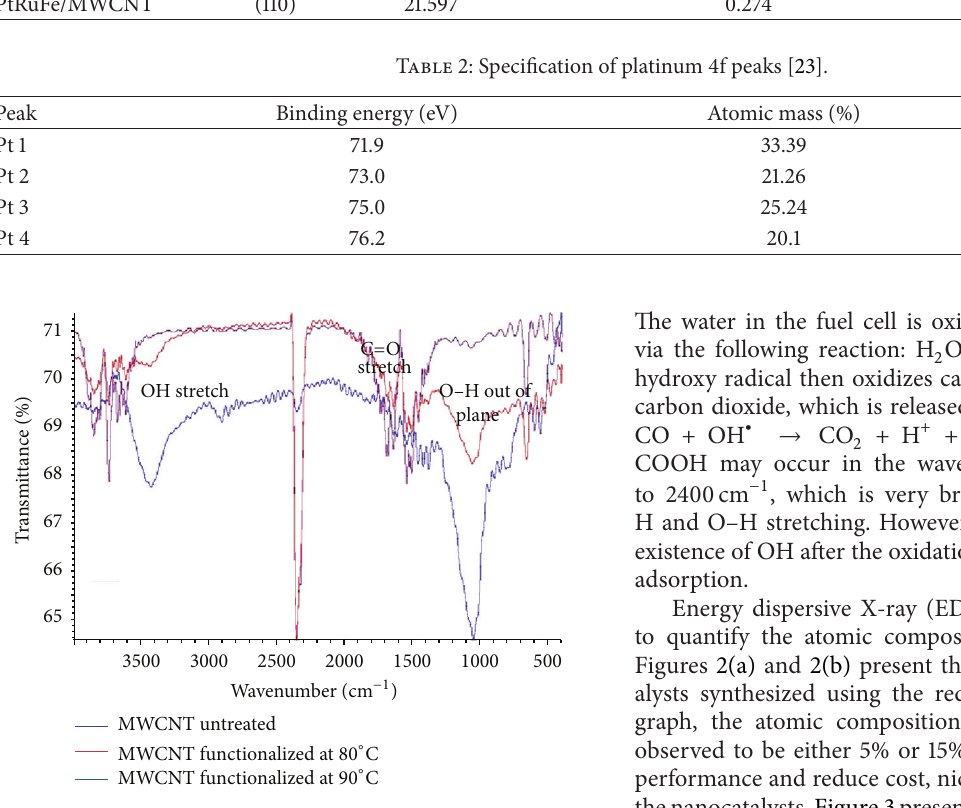
Figure 1: FT-IR analyses for pure MWCNTs before treatment and after treatment at 80 ∘ C and 90 ∘